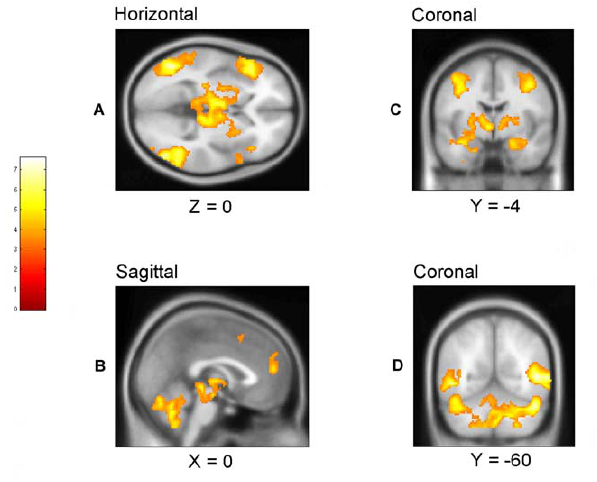
Figure 3. Areas of significant BOLD signal changes for the ‘amusement minus neutral’, ‘disgust minus neutral’, and ‘sexual arousal minus neutral’ conjunction null analysis conducted at the second level. Accompanying sagittal, coronal and horizontal slices through most ROIs are provided. BOLD signal changes for these slices are coregistered on top of normalized brain sections from the Montreal Neurological Institute (MNI) stereotaxic space template. Coordinates (x, y, and z) are given in mm and refer to locations in MNI stereotaxic space. Height threshold is set to p=0.001, uncorrected. The neurological convention has been chosen for orientation of coronal sections in all figures i.e., left is left and right is right. A: Medial prefrontal cortex, frontal operculum encroaching on anterior insula, thalamus, lateral occipital gyrus B: Medial prefrontal cortex, anterior cingulate, thalamus, brainstem, cerebellum C: Supple- mentary motor area, thalamus, amygdala D: Temporo-occipital junction, cerebellum.